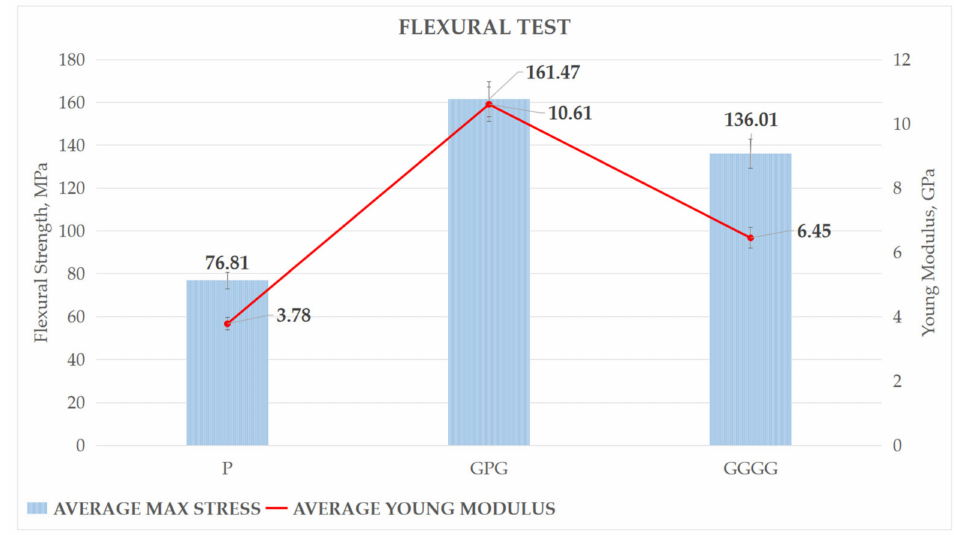
Figure 3. Flexural strength and young modulus of composites.